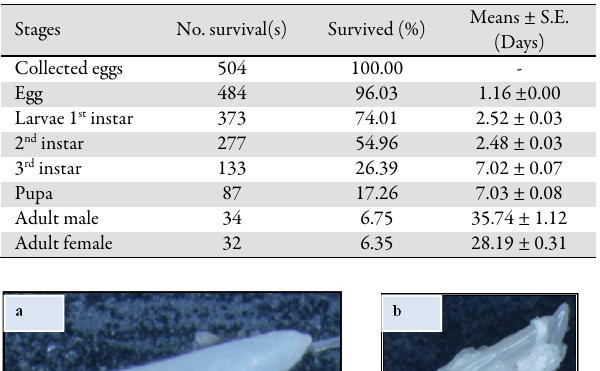
Table 1. Number of percentage (%) survival during the growth and development of A. helianthi Rossi Stages No. survival(s) Survived (%)